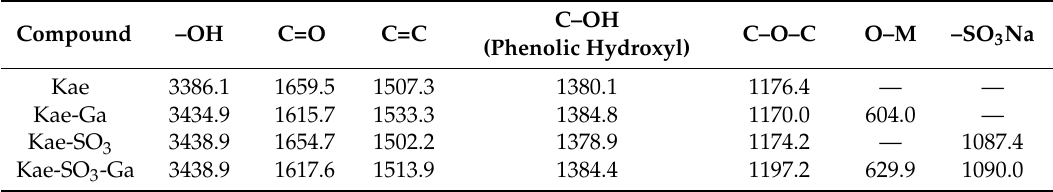
Table 4. Frequencies of characteristic absorption bands in Fourier transform infrared (FT-IR) spectra of Kae, Kae-Ga, Kae-SO 3 and Kae-SO 3 -Ga, respectively.